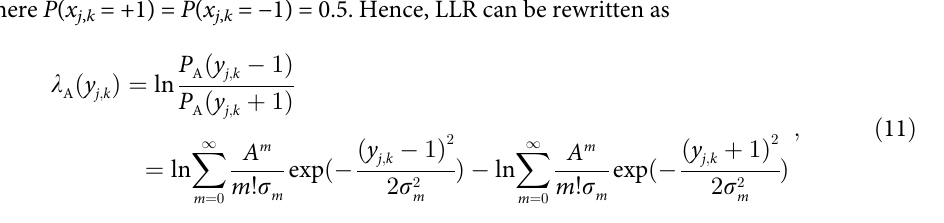
FFT BP decoding with the proposed initialization (i.e. the optimized FFT BP algorithm) for non-binary LDPC codes on AWAN channel is illustrated in Algorithm 1, where t denotes the